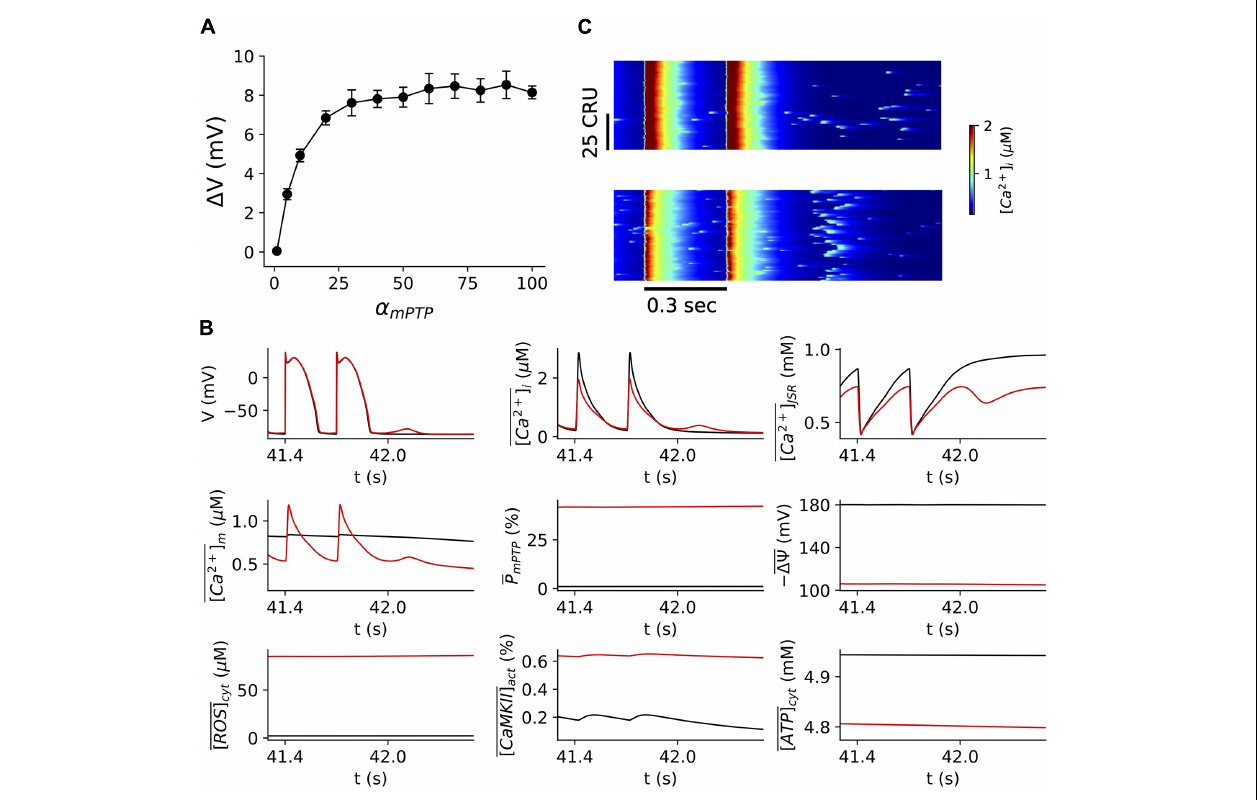
FIGURE 1 | Mitochondrial depolarization via mPTP opening promotes DADs. (A) The amplitude of DADs vs. α mPTP . The resting potential is –86.0 mV. Note that for the range of α mPTP in these simulations, we observed only one DAD after stopping pacing. (B) Time traces of V, (cid:2) Ca 2 + (cid:3) [ ROS ] cyt , [ CaMKII ] act , [ ATP ] cyt for normal control ( α mPTP = 1) in black and mitochondrial depolarization conditions ( α mPTP = 60) in red, respectively. The pacing cycle length is 300 ms, and we stopped pacing after 140 beats (i.e., 42 s). This pacing protocol was used throughout the whole study. (C) Linescan images of the cytosolic Ca 2 + for normal (top) and mitochondrial depolarization (bottom) conditions as in panel (B)